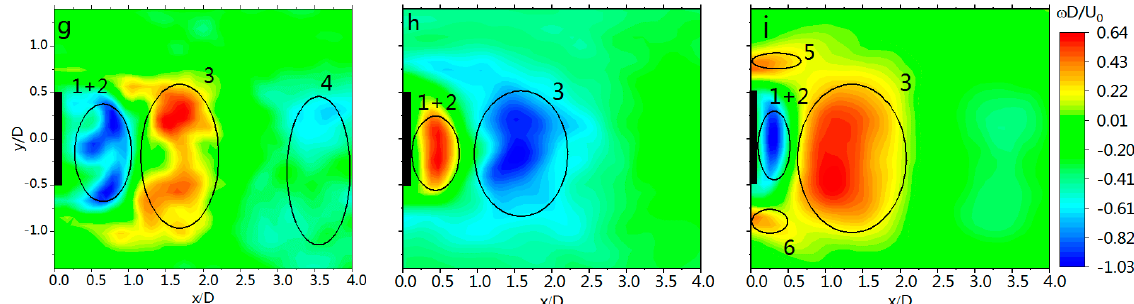
Figure 12. The modes of Proper Orthogonal Decomposition of Ar = 0.5: ( a ) Re = 1000, the zeroth-order mode (mean vorticity field); ( b ) Re = 2000, the zeroth-order mode (mean vorticity field); ( c ) Re = 5000, the zeroth-order mode (mean vorticity field); ( d ) Re = 1000, the first-order mode; ( e ) Re = 2000, the first-order mode; ( f ) Re = 5000, the first-order mode; ( g ) Re = 1000, the second-order mode; ( h ) Re = 2000, the second-order mode; ( i ) Re = 5000, the second-order mode.